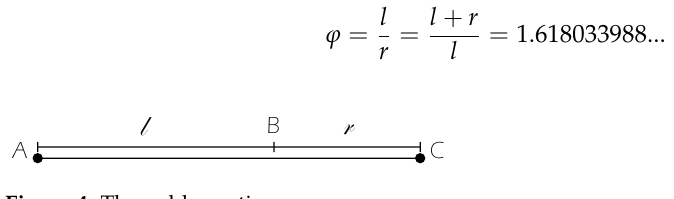
Figure 4. The golden